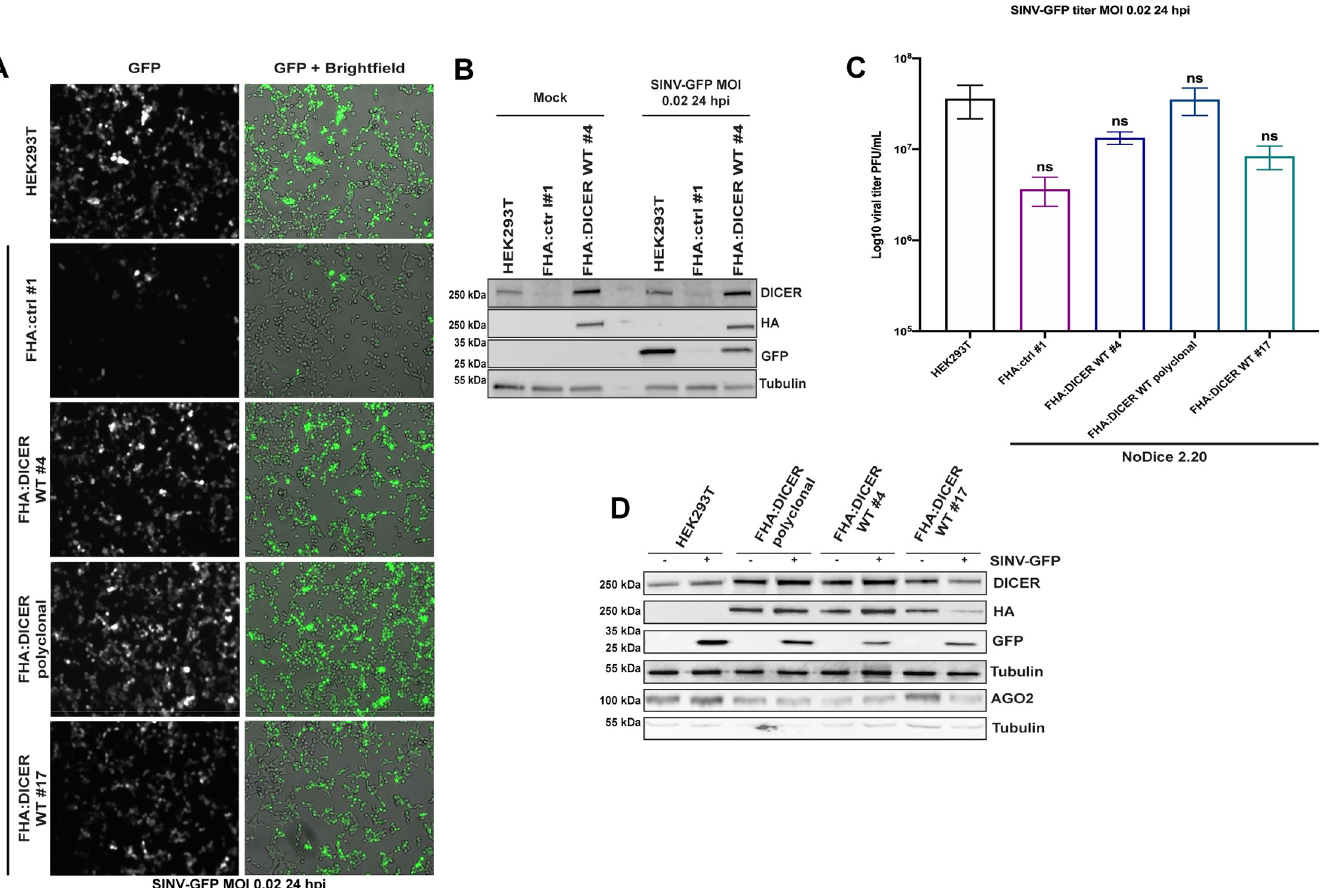
Fig 1. Analysis of SINV infection in HEK293T cells and characterization of FHA:DICER WT cell lines. A. GFP fluorescent microscopy pictures of HEK293T, NoDice FHA:ctrl #1 and FHA:DICER cell lines infected (polyclonal and two clones, #4 and #17) with SINV-GFP at an MOI of 0.02 for 24 h. The left panel corresponds to GFP signal from infected cells and the right panel to a merge picture of GFP signal and brightfield. Pictures were taken with a 5x magnification. hpi: hours post- infection. B. Western blot analysis of DICER (DICER and HA) and GFP expression in SINV-GFP-infected HEK293T, NoDice FHA:ctrl #1 and FHA:DICER cell lines shown in A. Gamma-Tubulin was used as loading control. C. Mean (+/- SEM) of SINV-GFP viral titers in the same cell lines as in A infected at an MOI of 0.02 for 24 h (n = 3) from plaque assay quantification. ns: non-significant, ordinary one-way ANOVA test with Bonferroni correction. D. Western blot analysis of DICER (DICER and HA) and AGO2 expression in HEK293T, NoDice FHA:ctrl #1 and FHA:DICER cell lines. Gamma-Tubulin was used as loading control.